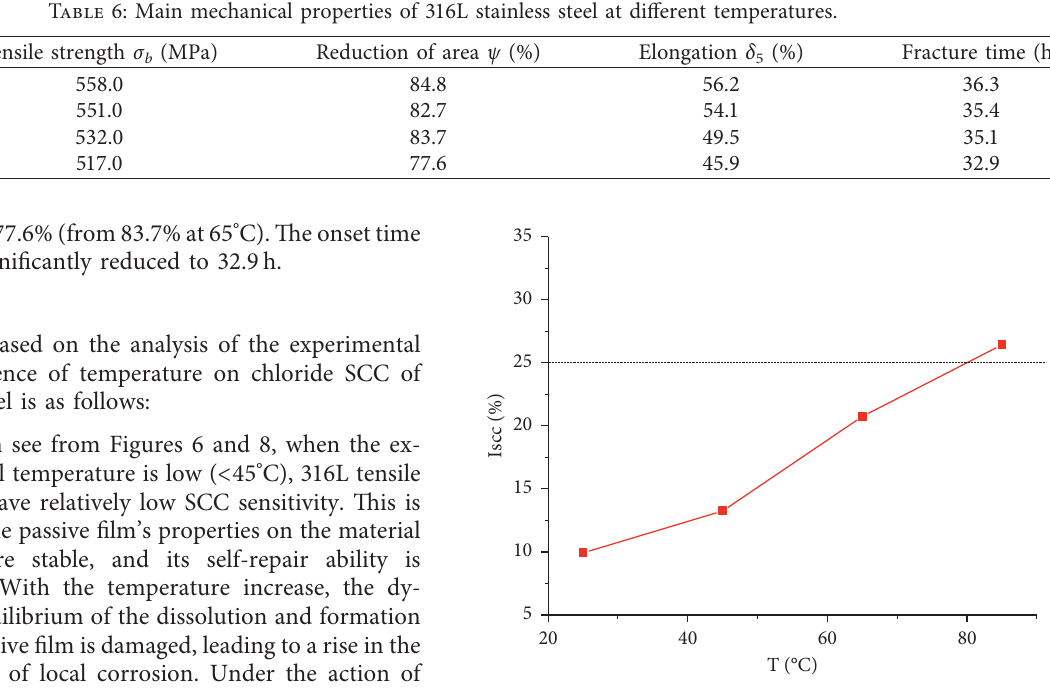
Figure 8: Stress corrosion cracking sensitivity index of 316L stainless steel at different